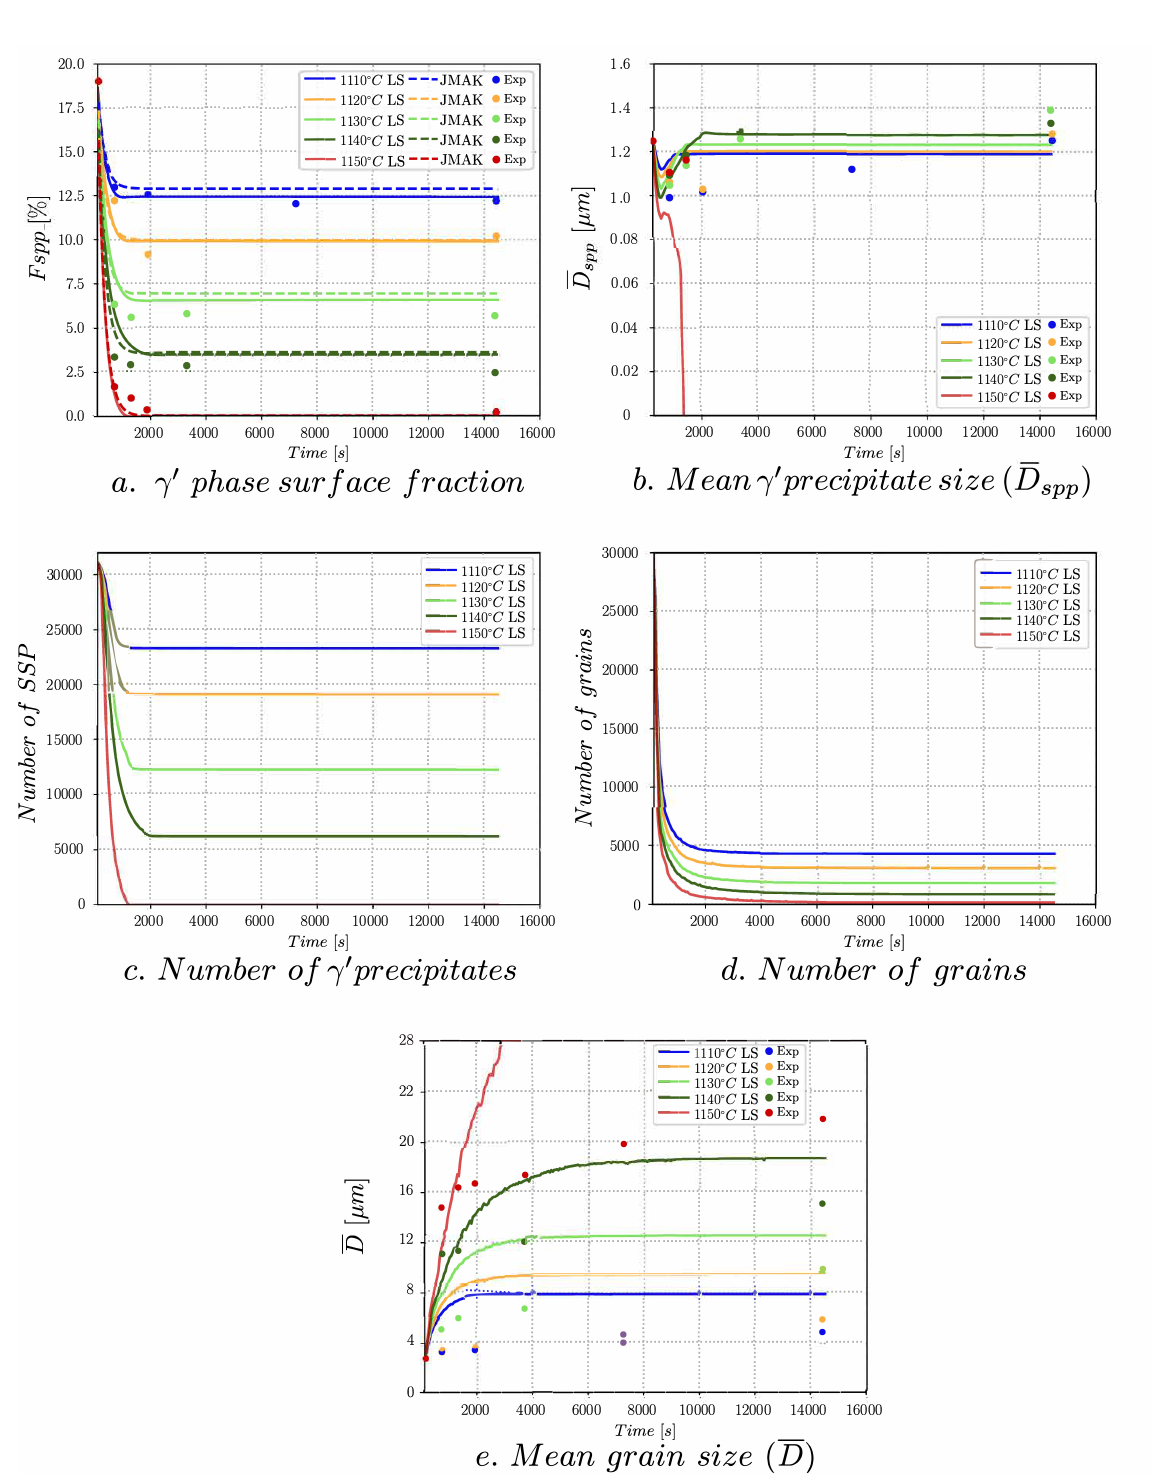
Figure 16. Simulation results for the N 19 superalloy without considering the PPB